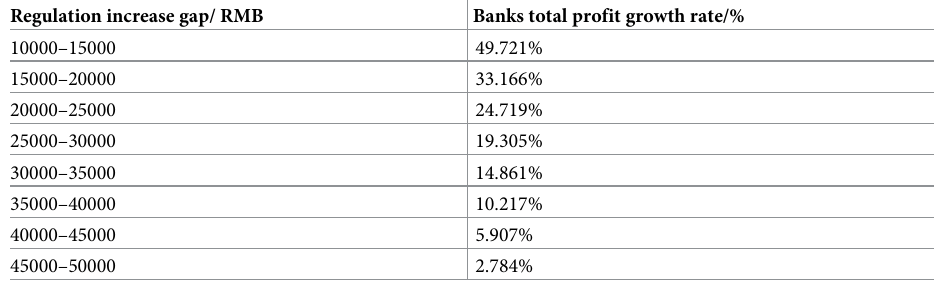
Table 3. The profit increase rate of different